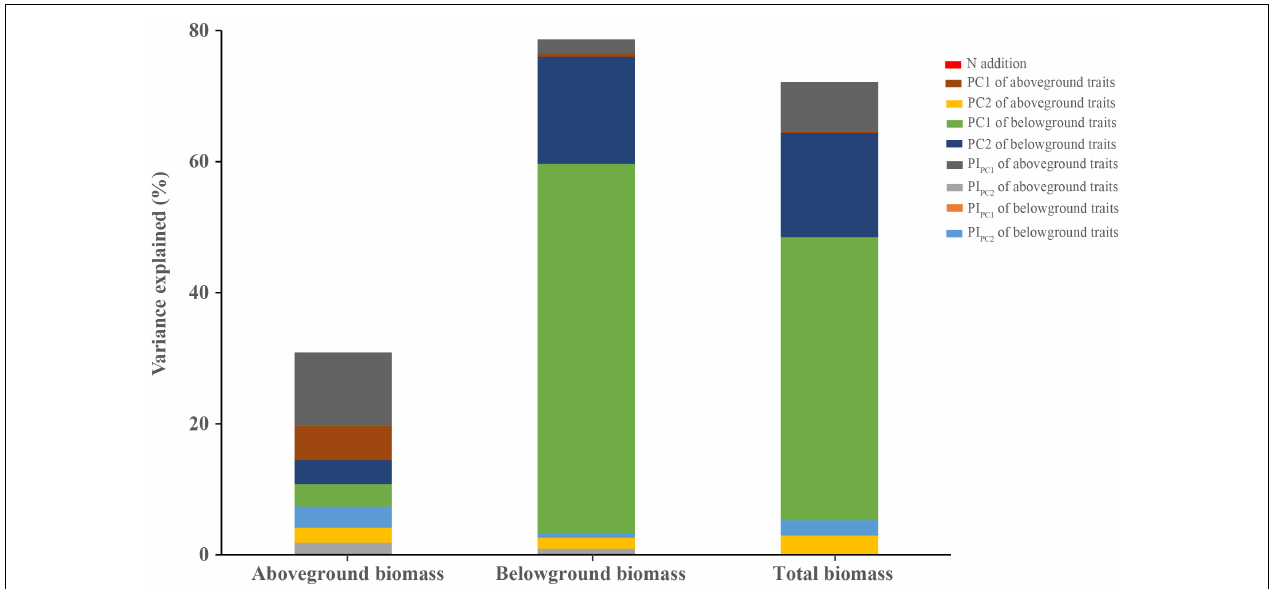
FIGURE 6 | Variance components show the unique portion of variation (percentage of total R 2 ) explained by each predictor in aboveground, belowground, and total biomass. The predictors used are N addition, plant functional traits (PC1 and PC2 of aboveground and belowground traits), and trait plasticity (PI PC1 and PI PC2 of aboveground and belowground